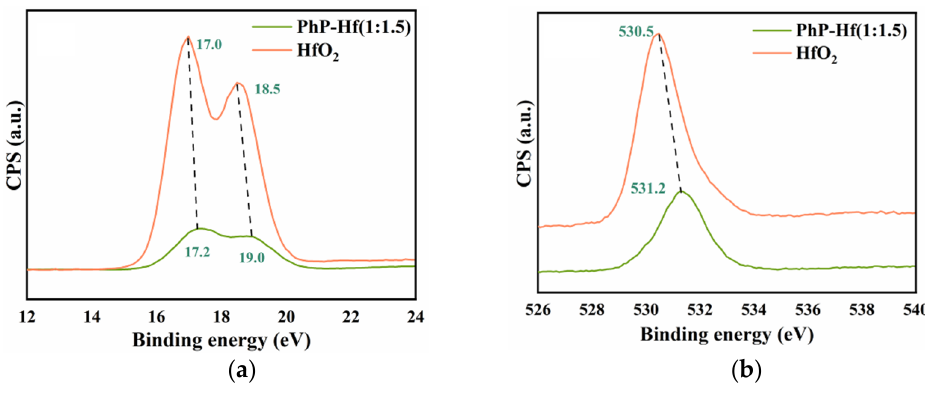
Figure 4. XPS spectra of ( a ) Hf 4f and ( b ) O1 s in PhP-Hf (1:1.5) and HfO 2 .